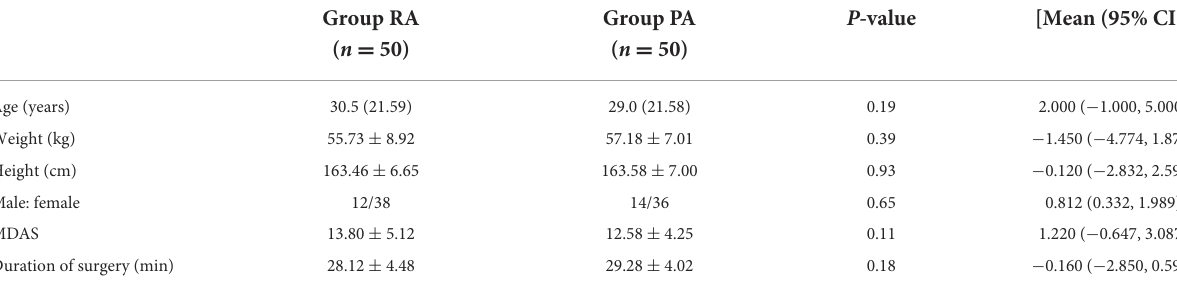
TABLE 2 Baseline demographic and clinical characteristics.